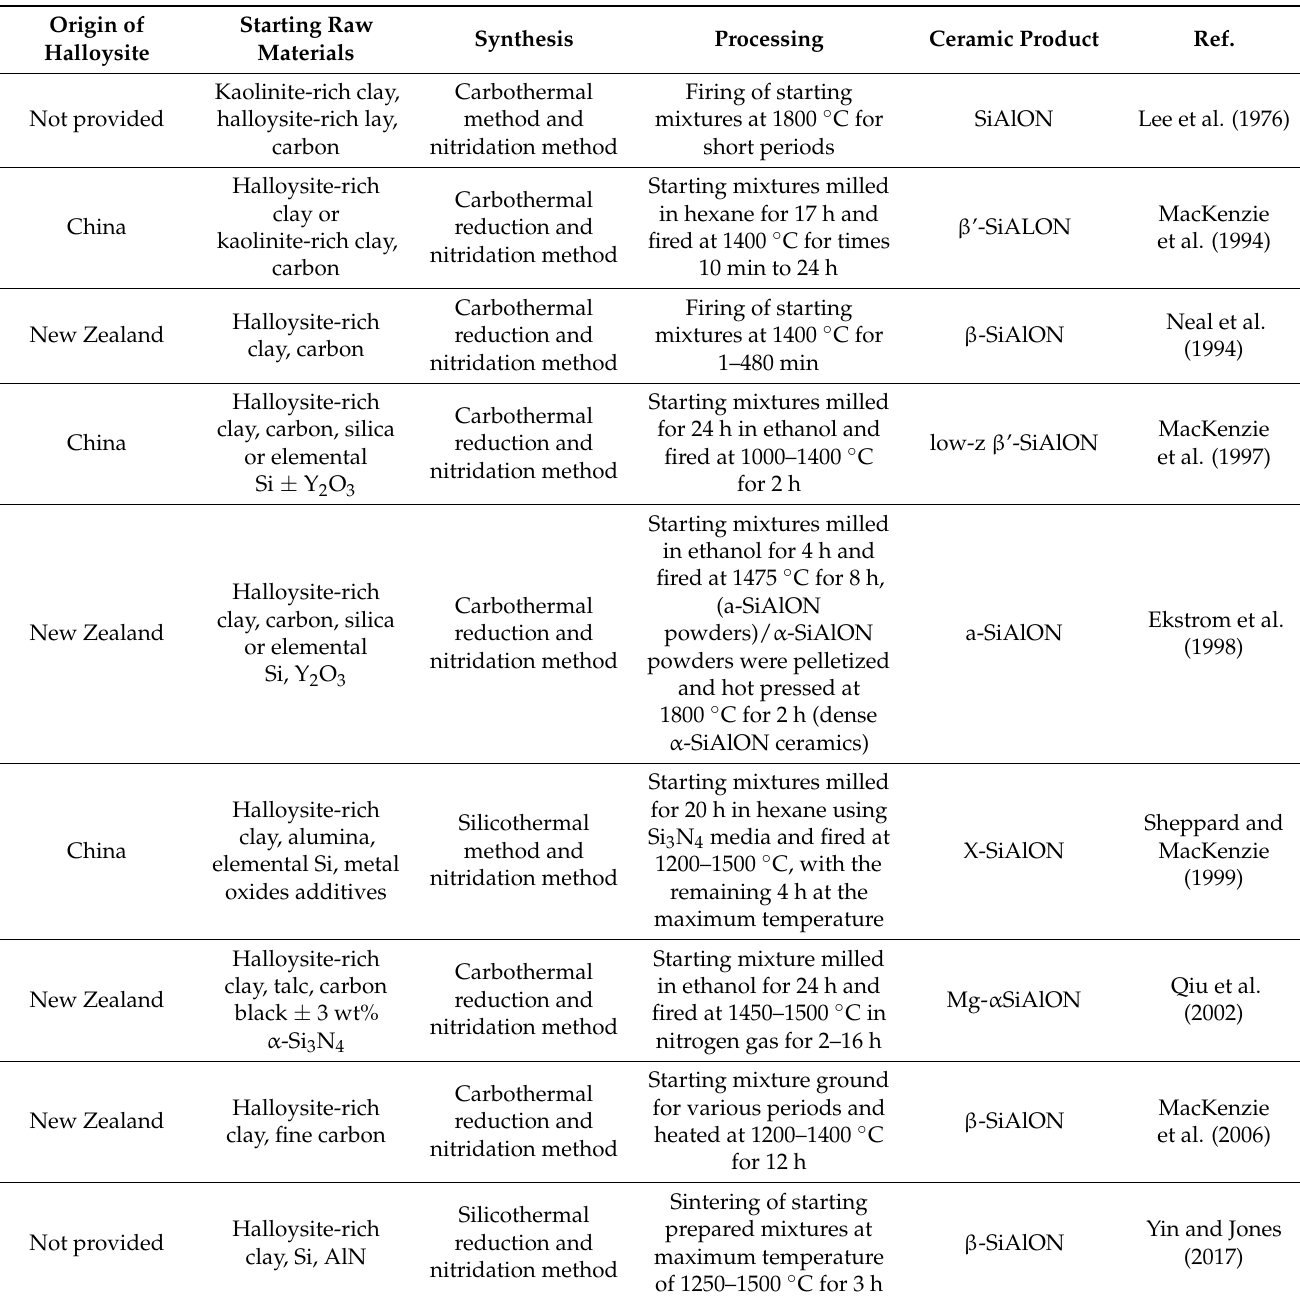
Table 2. Use of halloysite in advanced ceramic